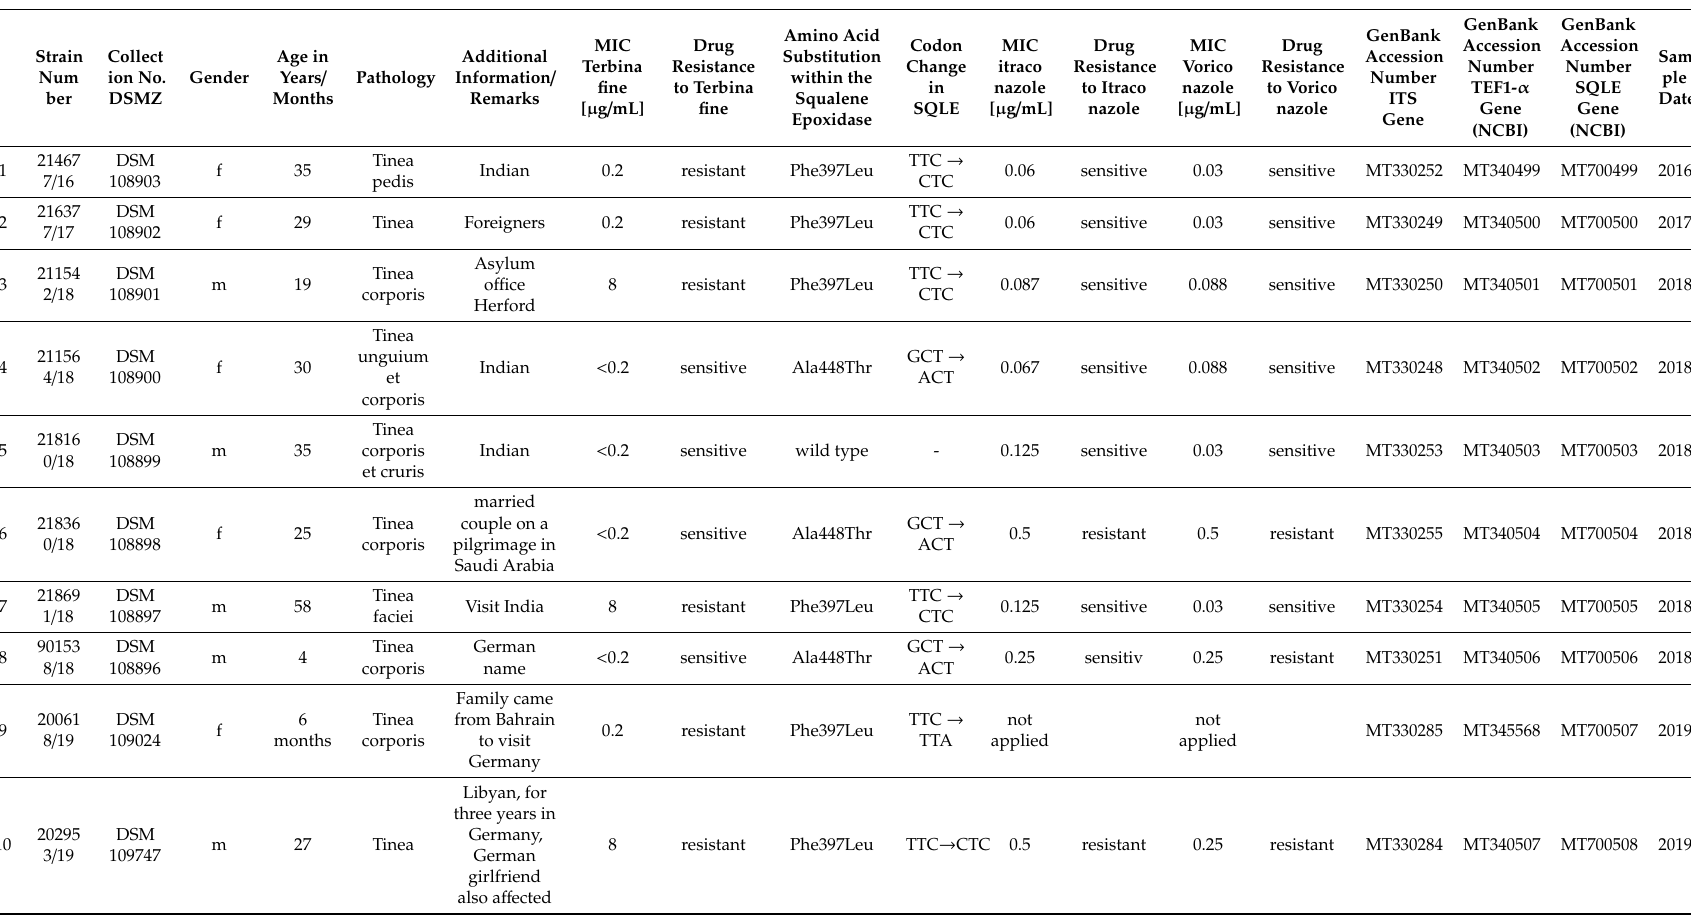
Table 1. Overview of the 29 patients with dermatomycoses due to T . mentagrophytes of (ITS) genotype VIII (India) diagnosed all over Germany from 2016–2020. Abbreviations: SQLE, squalene epoxidase; ITS, internal transcribed spacer; TEF1- α , translation elongation factor 1- α ; MIC, minimum inhibitory concentration;